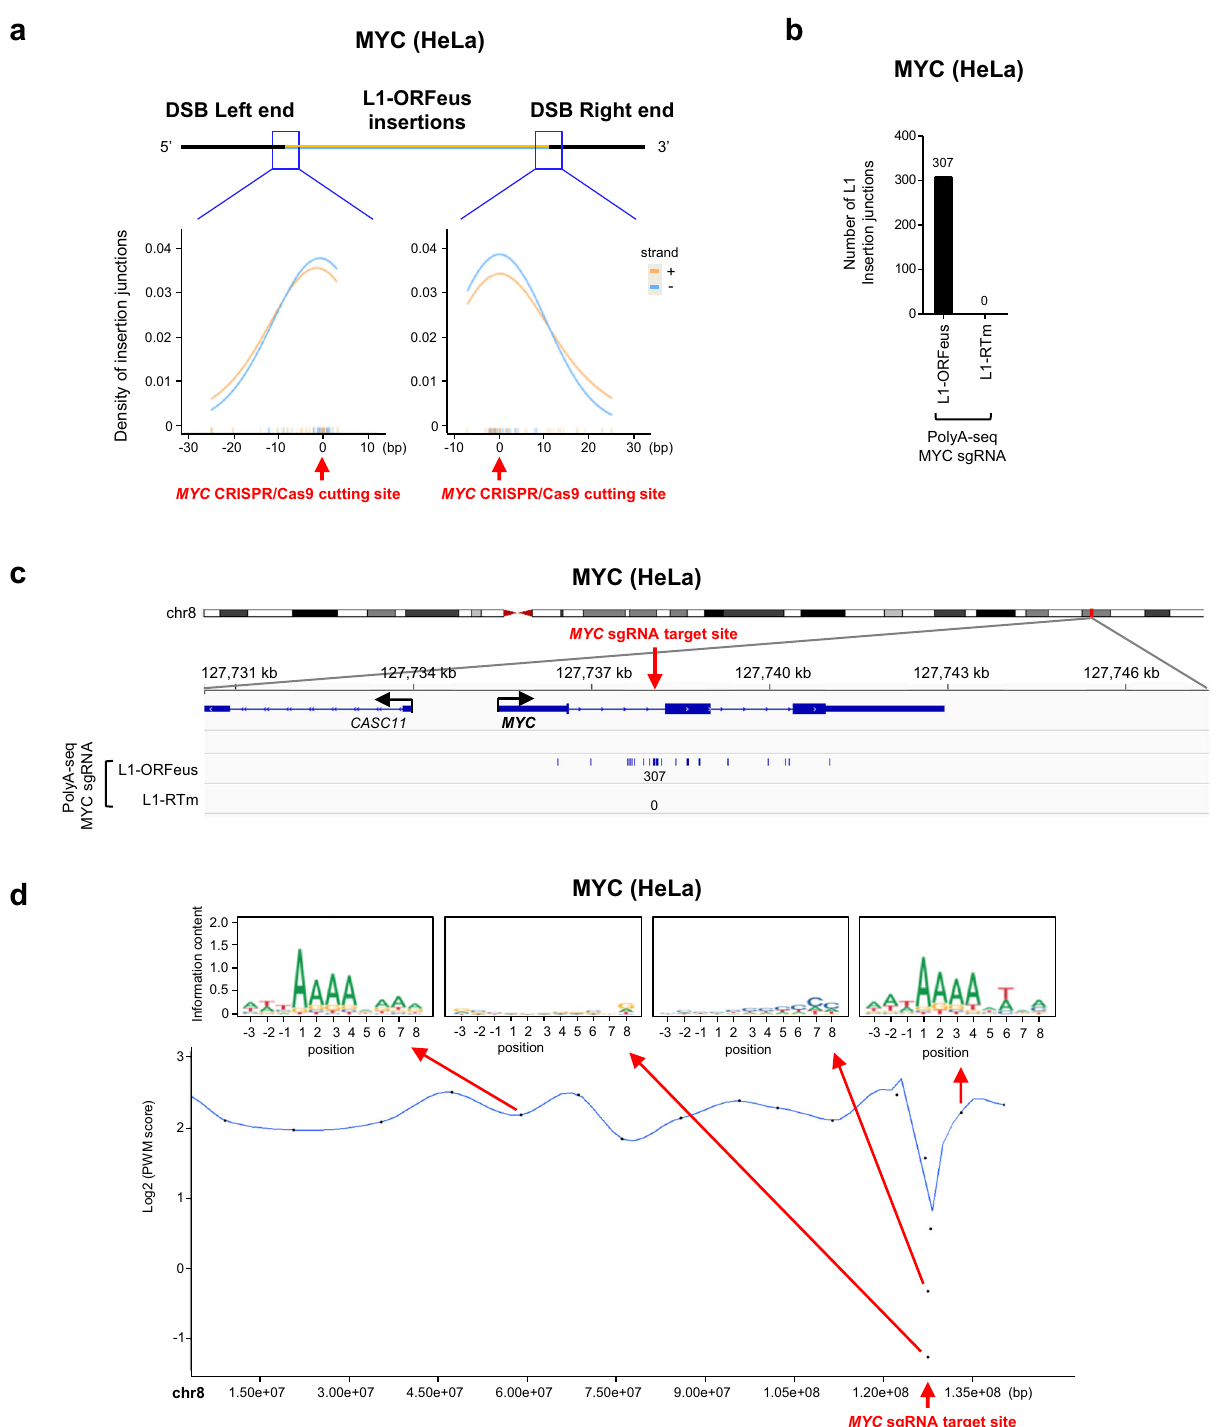
Fig. 5 RT-dependent de novo L1-ORFeus insertions at CRISPR/Cas9 target site in HeLa cells. a Detailed view of the distribution of L1-ORFeus insertions at the left or right end of the MYC locus obtained by amplicon sequencing at the MYC locus targeted by MYC CRISPR/Cas9 in HeLa cells expressing L1- ORFeus. b Numbers of L1-ORFeus insertions at the MYC locus obtained by PolyA-seq targeted by MYC CRISPR/Cas9 in HeLa cells that express L1-ORFeus or L1-RTm. c Detailed view of the distribution of L1-ORFeus insertions at the MYC locus obtained by PolyA-seq in HeLa cells targeted by MYC CRISPR/Cas9 expressing L1-ORFeus or L1-RTm. d Top: Sequence logo representing the consensus motif detected at L1-ORFeus pre-integration sites in example regions proximal or distant to the MYC CRISPR/Cas9 DSB. Each dot represents a chromosomal region encompassing 30 independent L1 insertions. Bottom: Spline interpolation curve of consensus motif position-weighted matrix (PWM) score in chromosome 8 obtained by PolyA-seq in HeLa cells targeted by MYC CRISPR/Cas9 that express L1-ORFeus. The mean interval size covered by the chromosomal region encompassing 30 independent L1-ORFeus insertions was: 235 bp (range 28 – 442 bp) within approx. ±5 kb of the MYC CRISPR/Cas9 target site, and 8,025,664bp (range 863,222 – 16,390,320 bp) outside of the CRISPR/Cas9 target